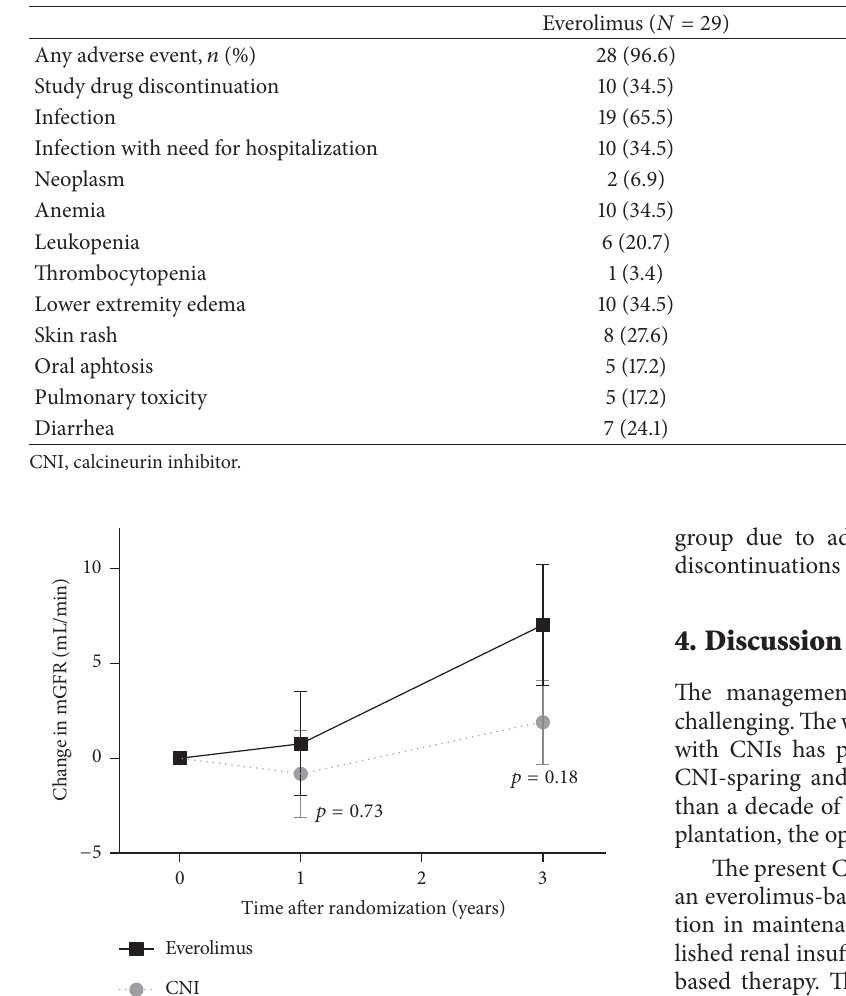
Table 3: Adverse events at year 3.